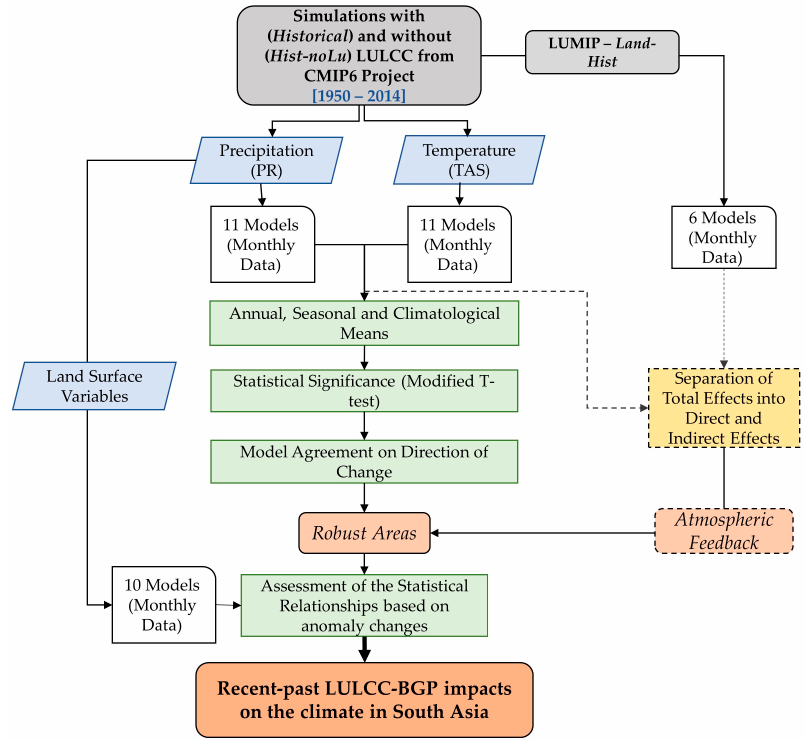
Figure 2. Methodological steps to the full-BGP effects of LULCC in South Asia based on the analysis of CMIP6-GCMs.